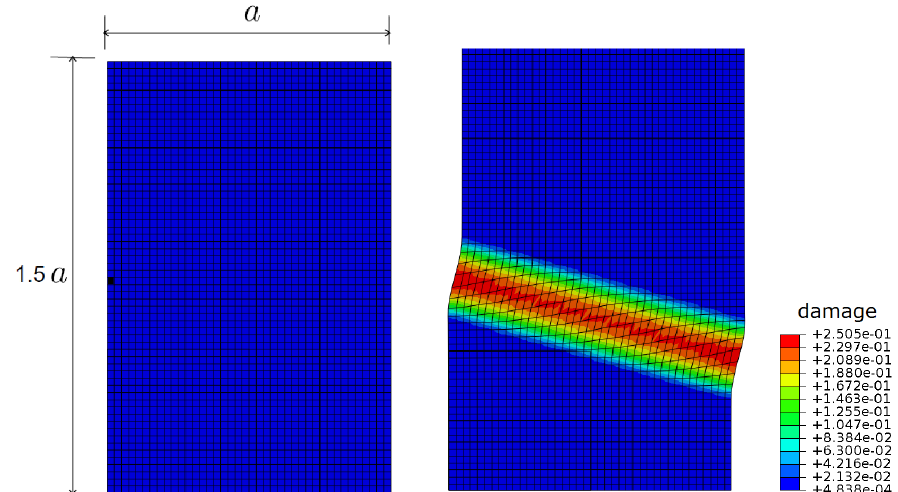
Figure 6. Regularized damage fields for a 25 ◦ rotated damage plane in clock-wise direction (contour maps of d